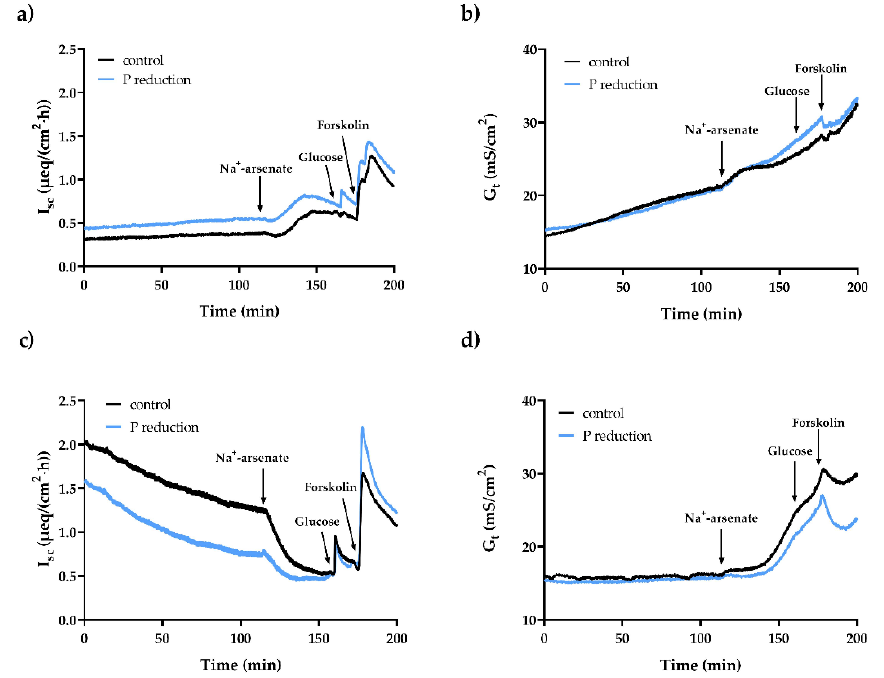
Figure 2. Effect of adding 5 mmol/L Na + -arsenate to the mucosal side of duodenal epithelia on the short-circuit current (I sc ) ( a ) and the tissue conductance (G t ) ( b ). Effect of adding 5 mmol/L Na + -arsenate to the mucosal side of ileal epithelia on the short-circuit current (I sc ) ( c ) and the tissue conductance (G t ) ( d